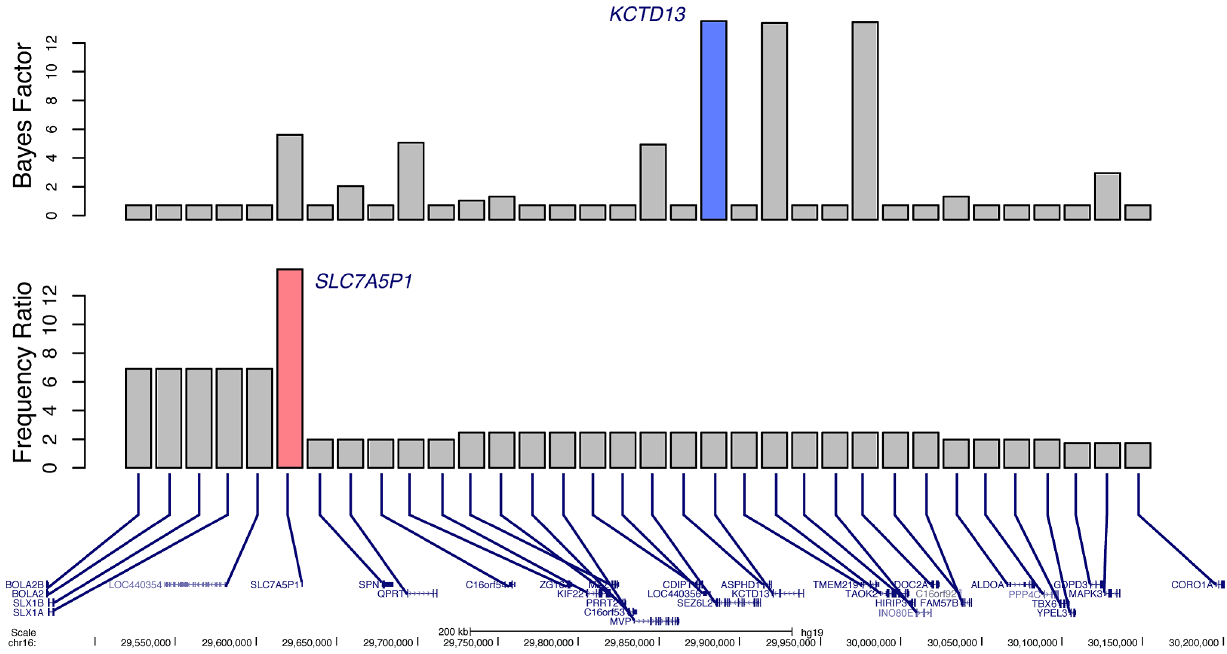
Figure 6. Prioritization of candidate genes at the 16p11.2 locus. Bottom . 34 RefSeq genes located within the 16p11.2 recurrent deletion. Middle . Ratio of deletion frequency of subjects with epilepsy to those referred for non-neurologic indications for each gene. The gene with the highest calculated ratio, SLC7A5P1 , is highlighted in pink. Top . Bayes factors for each gene; the highest scoring gene, KCTD13 , is highlighted in blue.